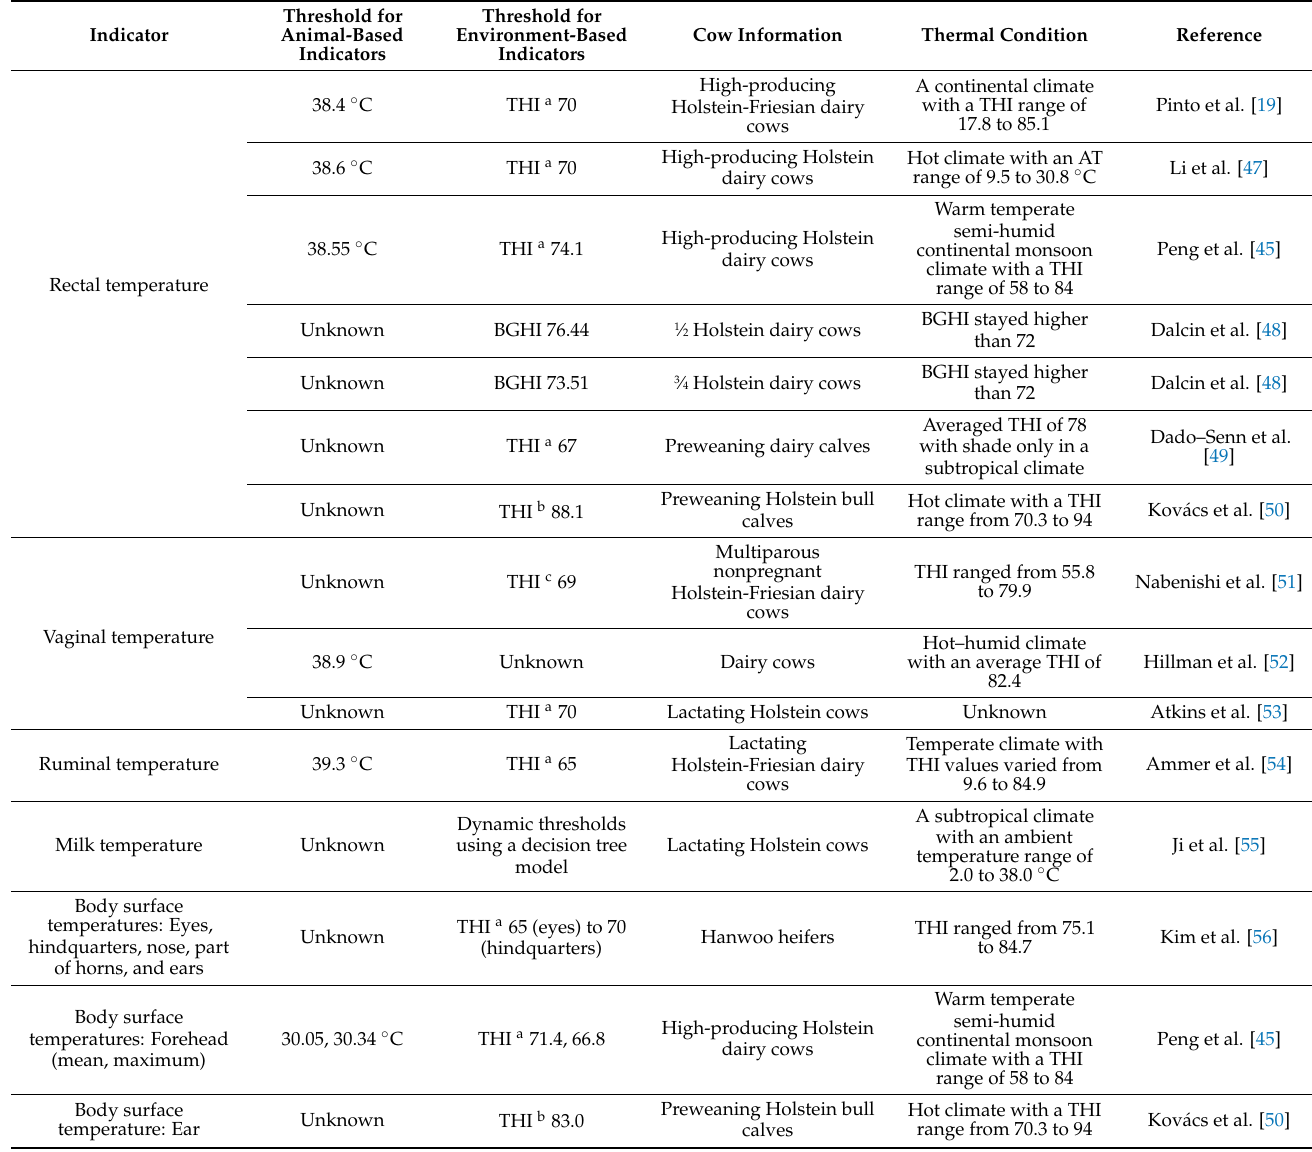
Table 2. Summary of the thresholds of body